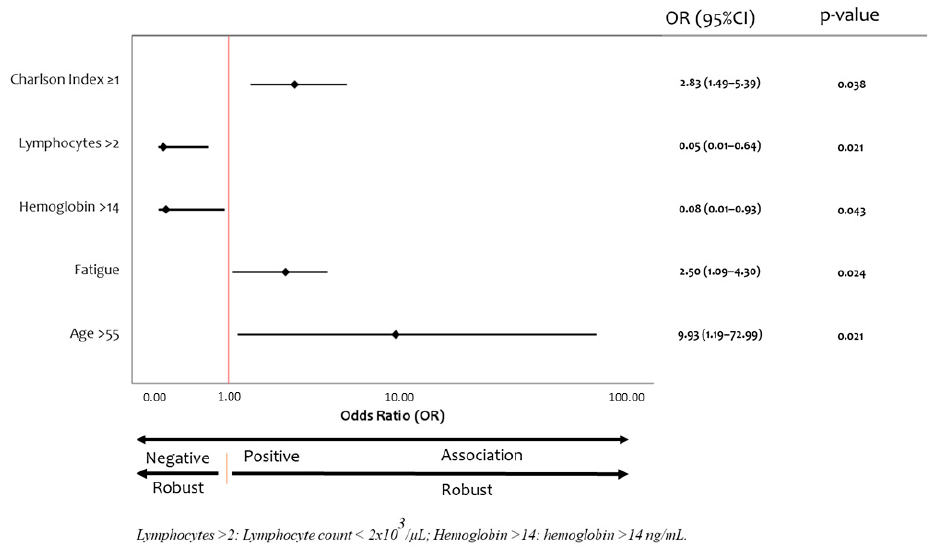
Figure 2. Factors associated with [ 18 F]FDG-PET/CT positive. Forest plot with odds ratios shown by closed circles and 95% confidence intervals by whiskers.